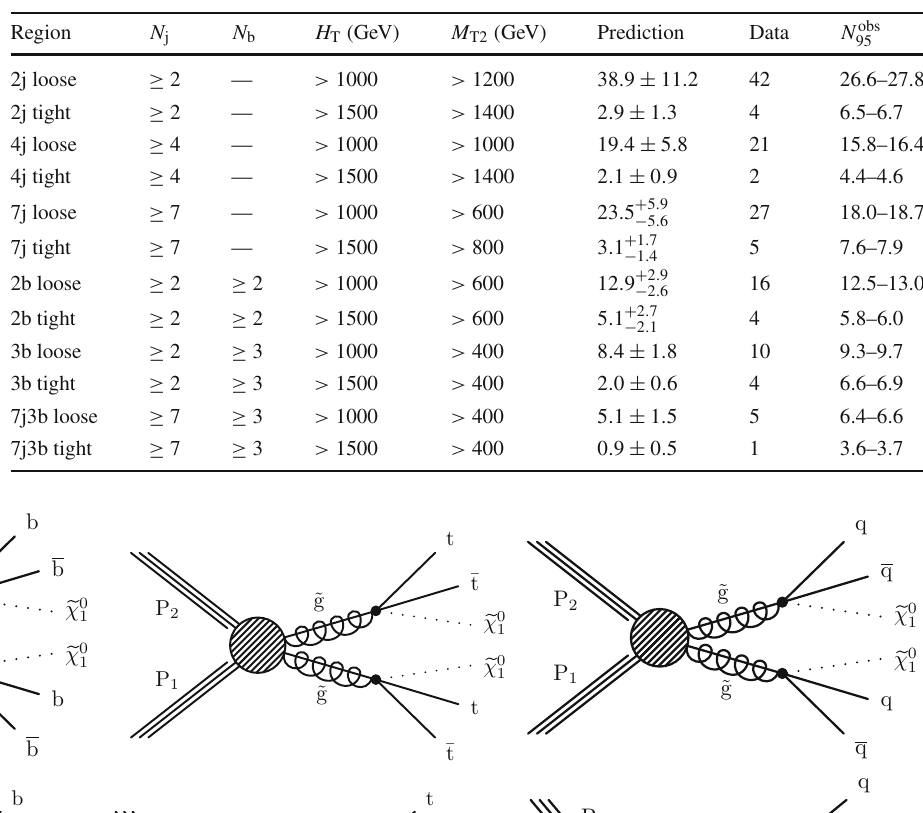
at least 50 expected events from simulation. The fraction